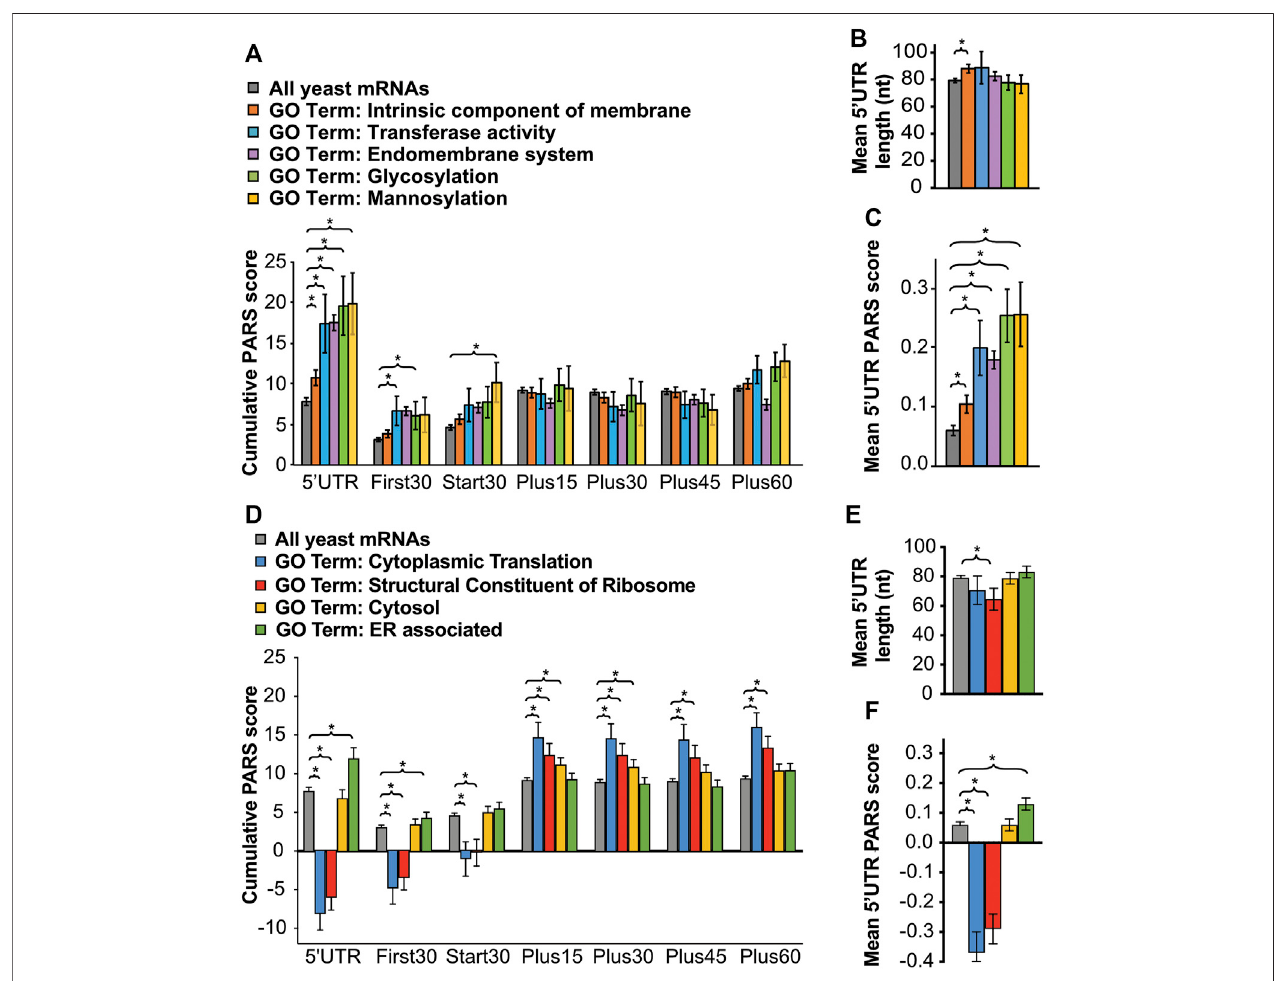
FIGURE 5 | RNAs encoding proteins traf fi cked through the ER and Golgi have long and structured 5 ′ UTRs, imposing a heightened requirement for eIF4B. Averaged cumulative (A , D) and single nucleotide (C , F) PARS scores and 5 ′ UTR lengths (B , E) for all genes associated with indicated gene ontology categories: intrinsic component of membrane (orange, n (cid:1) 1360), transferase (A – C , blue, n (cid:1) 86 ) , endomembrane system (purple, n (cid:1) 1098), glycosylation (A – C , green, n (cid:1) 87 ) , mannosylation (A – C ,yellow, n (cid:1) 46 ) ,cytoplasmictranslation (D – F ,blue, n (cid:1) 161 ) ,structuralconstituentofribosome(red, n (cid:1) 190),cytosol (D – F ,yellow n (cid:1) 426 ) ,or ER associated (D – F , green, n (cid:1) 405 ) for each 5 ′ -UTR or CDS interval described as in Figure 4A , with p values from Student ’ s t test indicated (* p < 0.05).